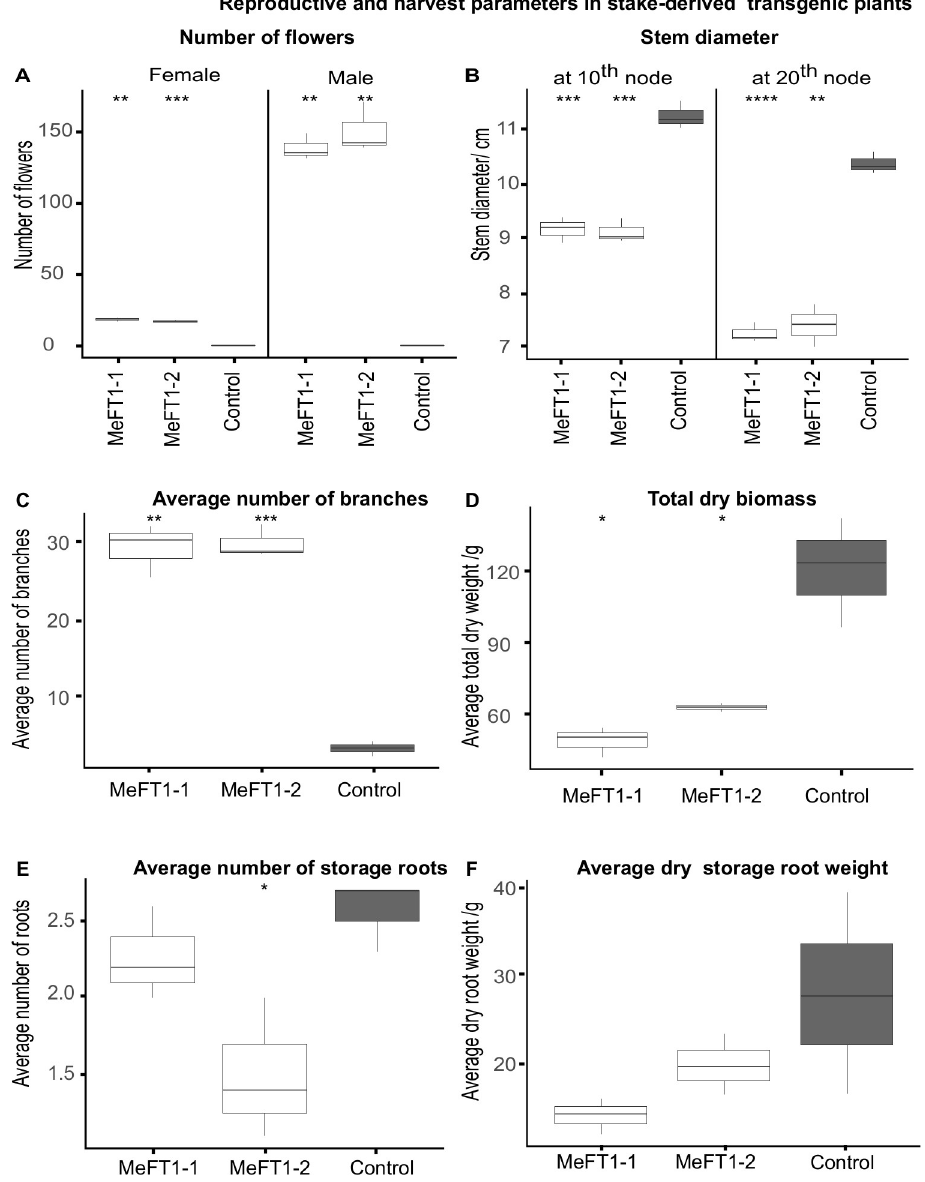
Fig 5. Growth and harvest parameters of MeFT1 overexpressing and somatic embryo-derived non-transgenic control plant lines assessed at 200-day growth period in the greenhouse. ( A ) Average number of male and female flowers, ( B ) average number of branches produced per plant, ( C ) average stem thickness, ( D ) total dry weight of shoot and storage roots, (E) average number of storage roots per plant and (F) average storage root weight. n = 30 independent plants per plant line in all cases except for (C) in which n = 10 independent plants. Two-way Student’s t test was performed to compare means of transgenic and non-transgenic embryo derived controls. � P � 0.05; �� P � 0.01; ��� P � 0.001, ���� P � 0.0001. ggplot2 of R software was used to construct box plots. The middle line in the box shows the median value. Data ranging from smallest value to lower quartile represents lower whisker while values between upper quartile and largest correspond to upper whisker. Values below and above median represent lower and upper quartile of roughly 1.5IQR each. emergence (Fig 5A). Plants of MeFT1-1 and MeFT1-2 both produced significantly more male (average 144.1) than female (average 17.6) flowers per plant. Since branching is a precursor to flowering in cassava, we counted and compared the number of branches produced by each